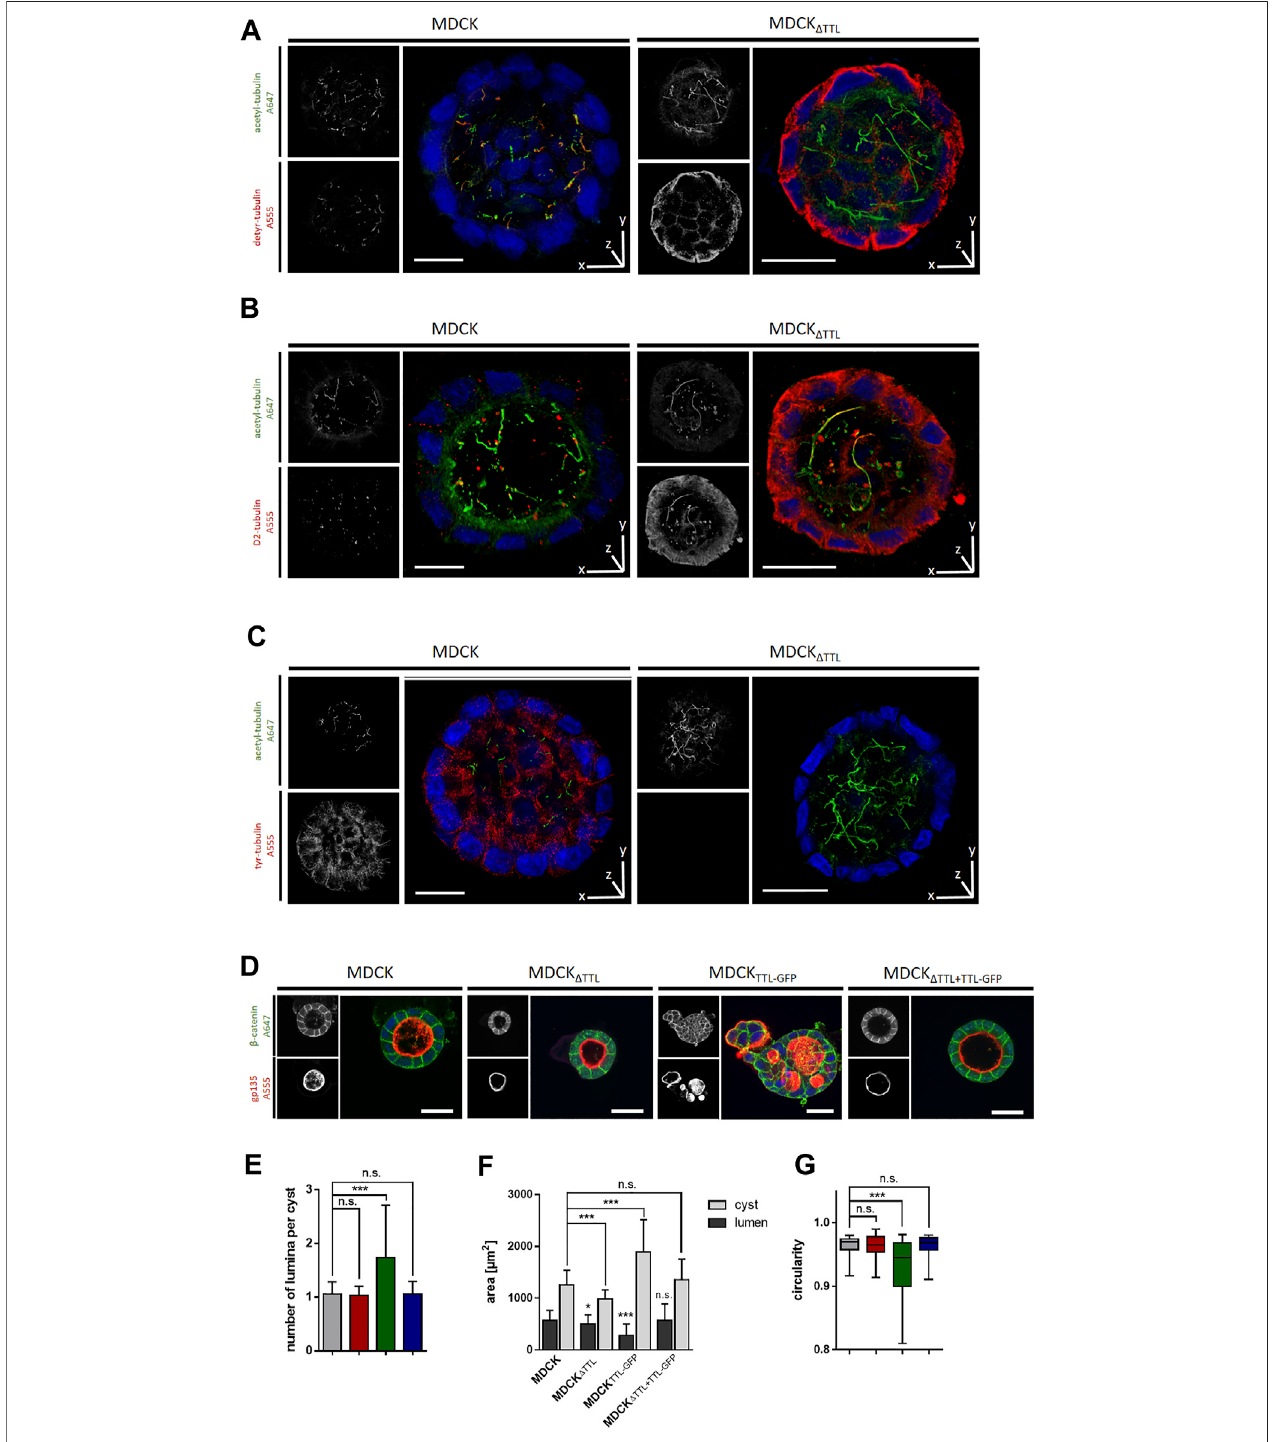
FIGURE8 | TTL-expression dependent tubulin PTMs in primary cilia. (A – C) 3D-rendered depiction ofMDCK and MDCK Δ TTL cellsculturedin Matrigelfor 7 days at 37 ° C and a humidi fi ed atmosphere of 5% CO 2 in air. Cysts were stained with antibodies directed against acetylated tubulin (green) and detyr-tubulin (red) in (A) , D2- tubulin (red) in (B) and tyr-tubulin (red) in (C) . Distribution of tubulin PTMs were analyzed by confocal microscopy. Scale bars: 20 µm. (D – G) MDCK, MDCK Δ TTL , MDCK TTL-GFP and MDCK Δ TTL+TTL-GFP cells were cultured as described above. Polarity of cysts was analyzed by confocal microscopy. Cysts were stained with antibodiesdirected againstlateral β -catenin (green)andapicalgp135(red). Scalebars:30 µm. (E – G) Lumennumbers (E) ,cystandlumen areas (F) andthecircularityof cysts (G) were quanti fi ed by using ImageJ analysis tools. Mean ± s.d., n = 3 independent experiments per cell line. A total of 7 – 10 cysts were analyzed per experiment and cell line. Mean ± s.d., n = 3. Statistical signi fi cance was tested using one-way ANOVA with Dunnet ’ s comparison (n.s., not signi fi cant; *** p < 0.001).